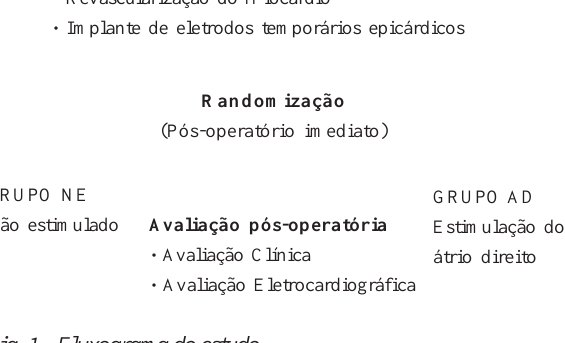
Fig. 1 - Fluxograma do